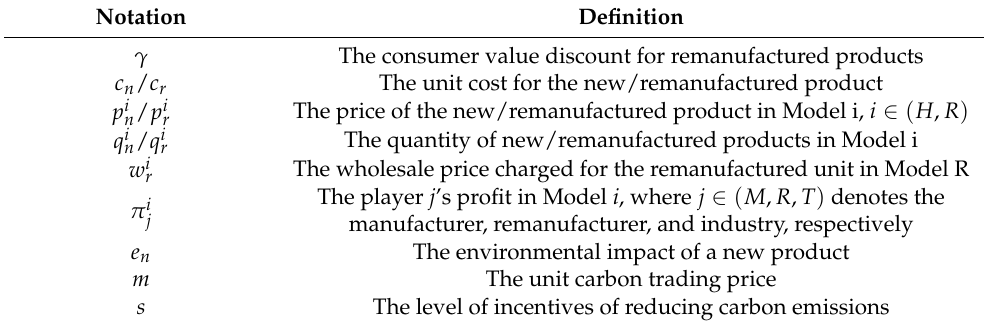
Table 2. Main notations used in this